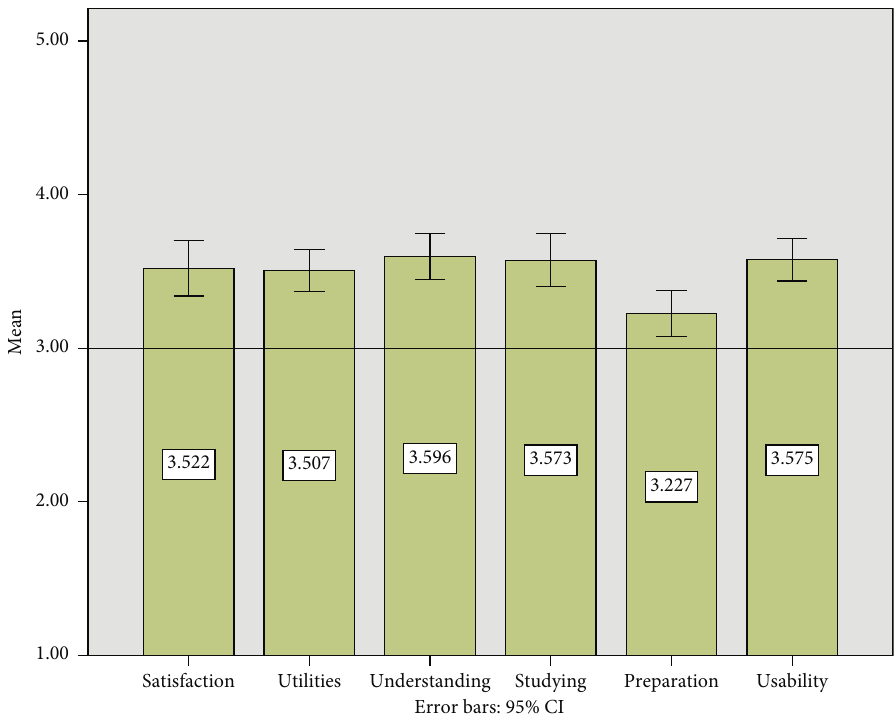
Figure 6: The subscale means of students’ satisfaction. Table 8: t -tests for subscales’ paired